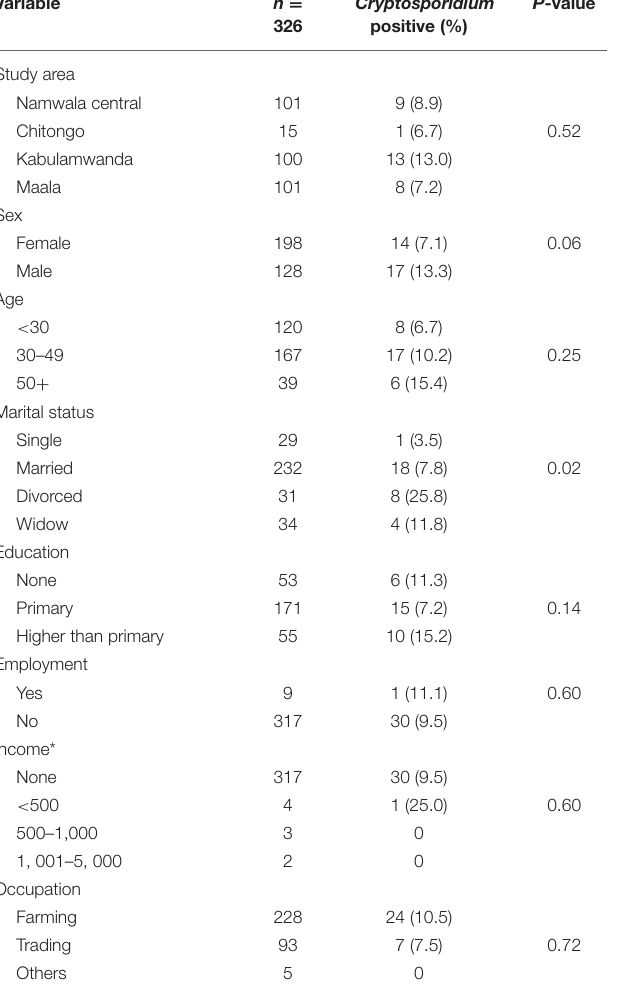
TABLE 2 | Association of Cryptosporidium and environmental characteristics for the adult HIV positive population ( n = 326).